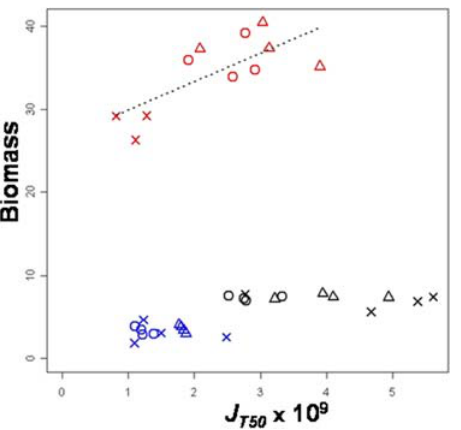
Figure 4. Relationship between biomass and glucose con- sumption rate. Biomass is defined as the product of carrying capacity by cell size. Each point corresponds to the mean value of a strain in a culture condition. Blue, black and red colors correspond respectively to 0.25%, 1% and 15% glucose. Vinery strains are represented by circles, brewery ones by crosses and bakery ones by triangles.